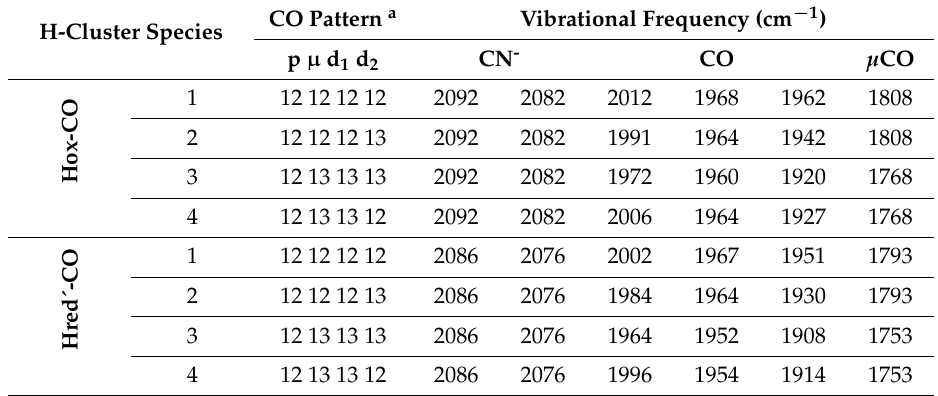
Figure 6. Pure IR spectra of Hred´-CO isotopomers 1 – 4. Spectro-electrochemical experiments yielded pure IR spectra for Hox-CO (dotted lines) and Hred´-CO (solid lines) after the subtraction of the minor IR contributions of other H-cluster species, such as Hred and Hsred, and the other isotopomers of Hox-CO/Hred´-CO (compare Figure 5). The CO/CN − stretching frequencies for Hred´-CO are annotated. Table 1. CO/CN ‒ stretching frequencies of CO-inhibited H-cluster isotopomers a .